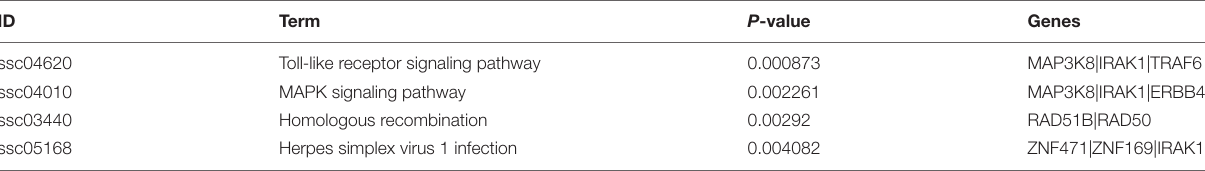
TABLE 1 | Summary of KEGG pathways associated with miR-146a-5p.